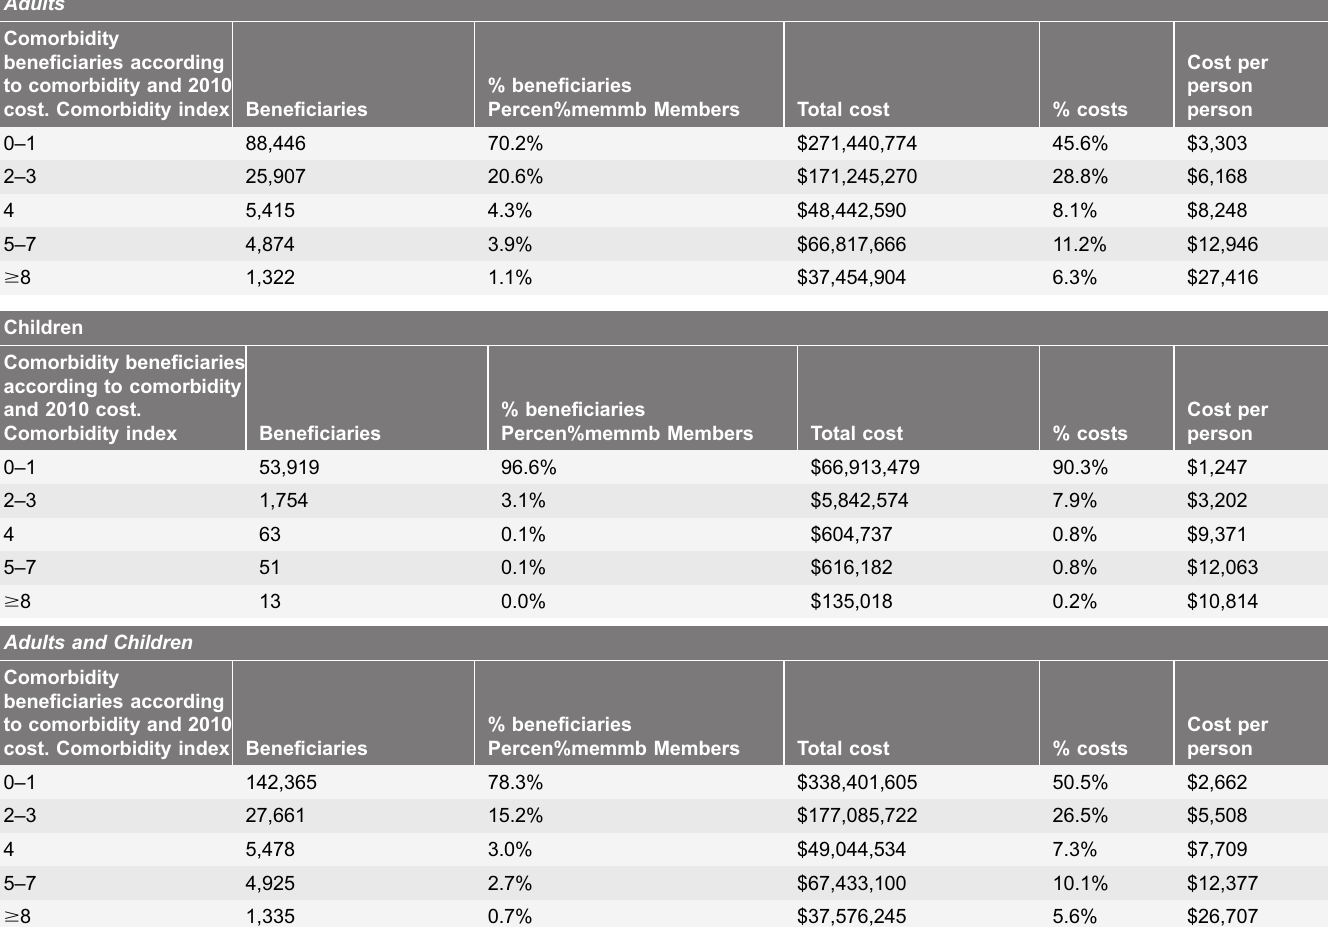
Table 2. Beneficiaries and 2010 health care costs according to the prior year Charlson comorbidity